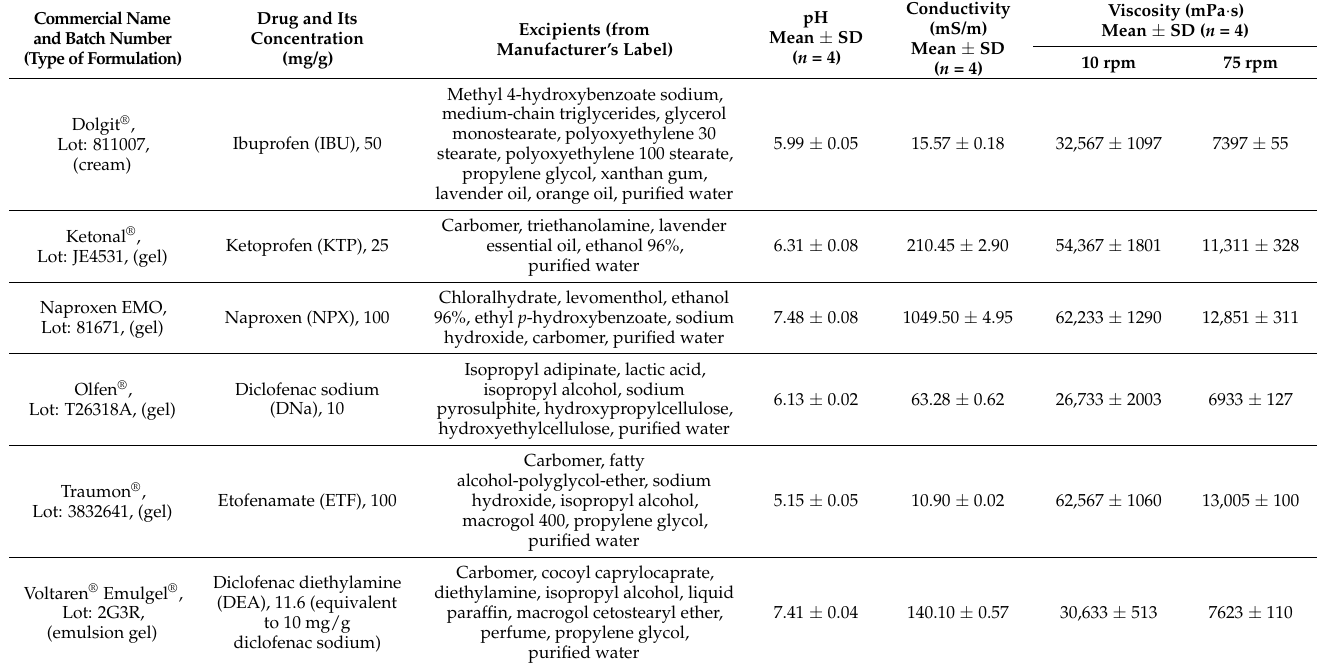
Table 1. Characteristics of commercial topical products with